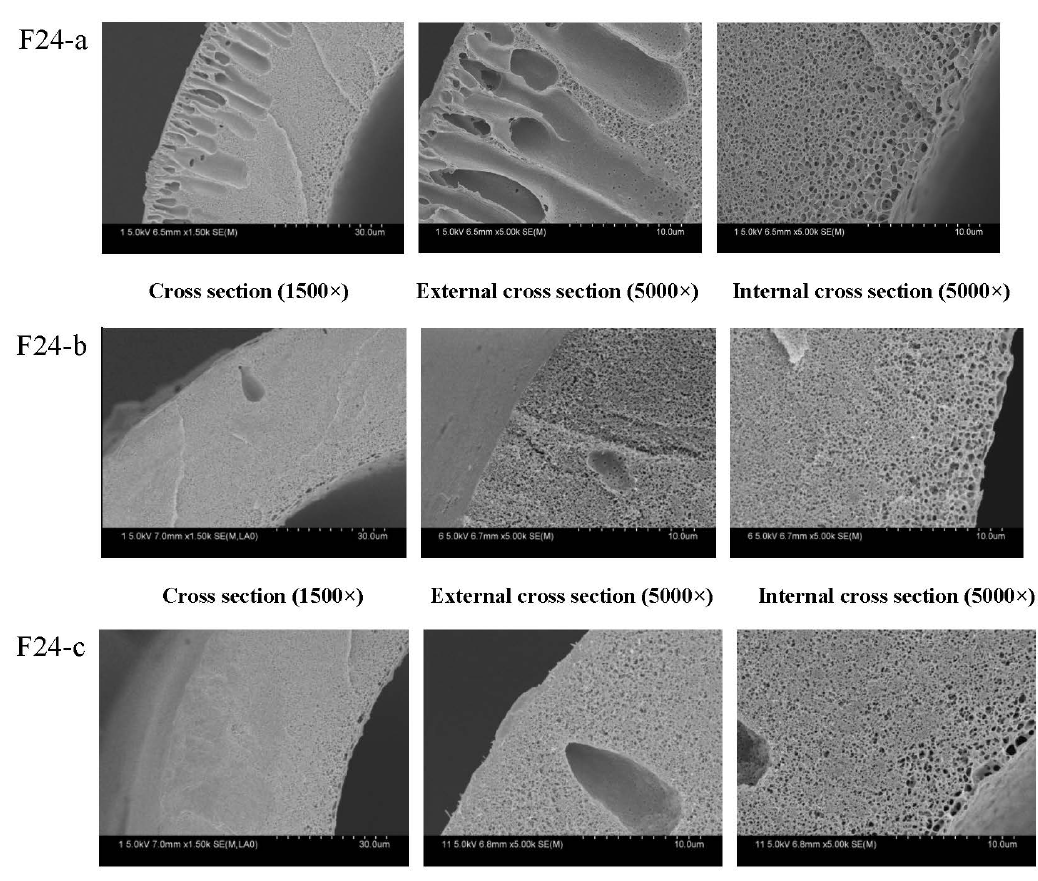
Figure 10. The effect of PEG content on the microstructure of PVDF hollow fiber membrane percentage: ( a ) 14.8% (w/w); ( b ) 16.8% (w/w); ( c ) 18.8% (w/w). The preparation parameters of PVDF membranes were shown in Table 1. The inner diameter and different wall thickness of PVDF hollow fiber membranes are 200 and 40 μ m,